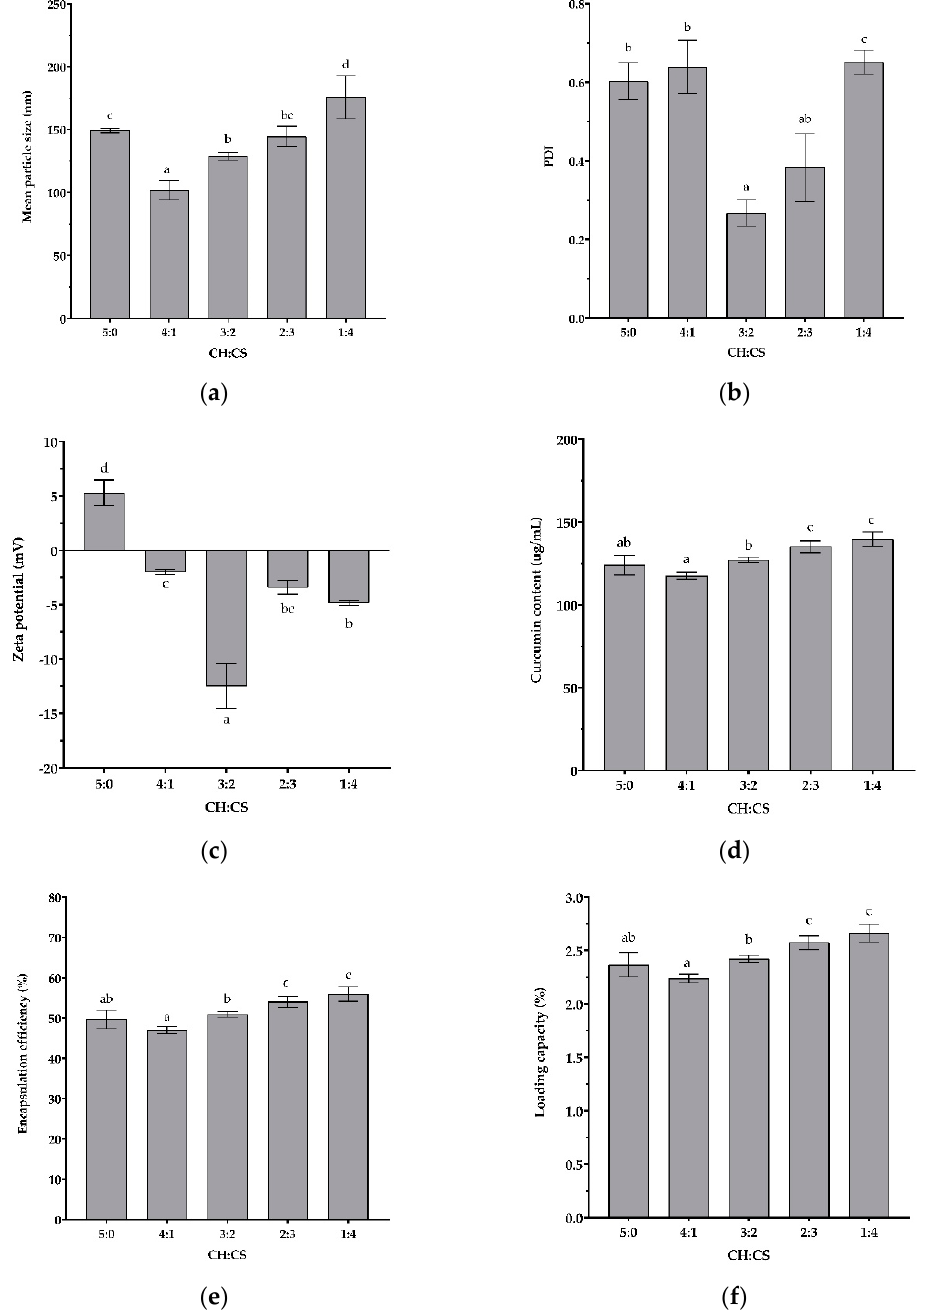
Figure 4. Effects of chitooligosaccharides: chondroitin sulfate (CH:CS) ratio on nanoparticle charac- teristics: ( a ) mean particle size; ( b ) polydispersity index (PDI); ( c ) zeta potential; ( d ) curcumin content; ( e ) encapsulation efficiency; ( f ) loading capacity. Values with different letters differ significantly ( p < 0.05).